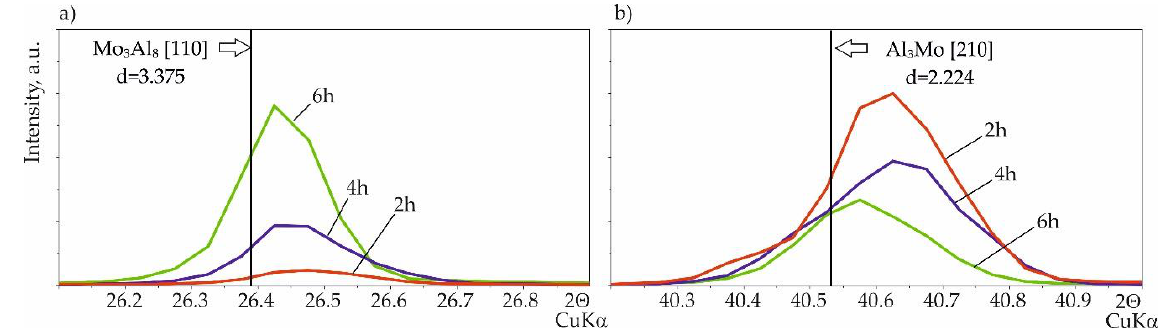
Figure 4. XRD pattern of Si-Al coating obtained on TZM alloy with a quantity of slurry 0.15 g/cm 2 at temperature 1000 °C in 2 h (red color), 4 h (blue color), 6 h (green color); ( a ) the part within the angle range from 26.1 to 26.9; ( b ) the part within the angle range from 40.2 to 41.0.